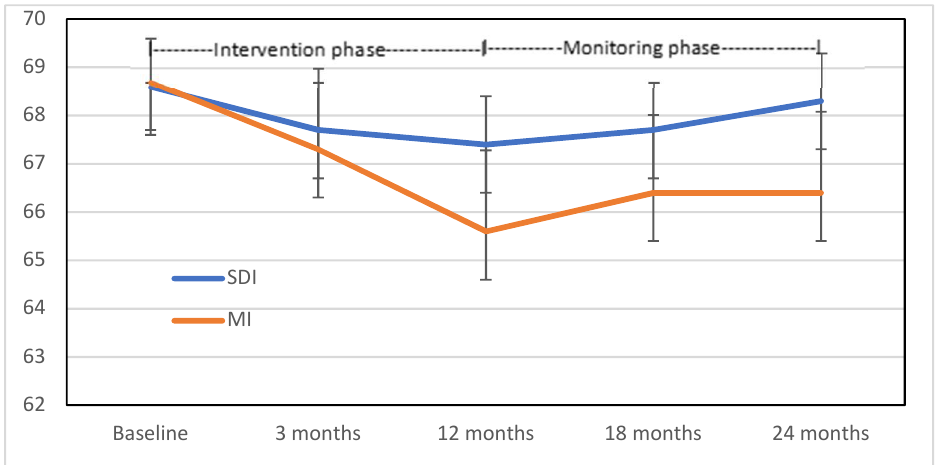
Figure 2. Mean (95% CI) weight (kg) for the Motivational Interviewing (MI) group and the Self-Directed Intervention (SDI) group over 24 months (ITT analysis) ( n = 54).